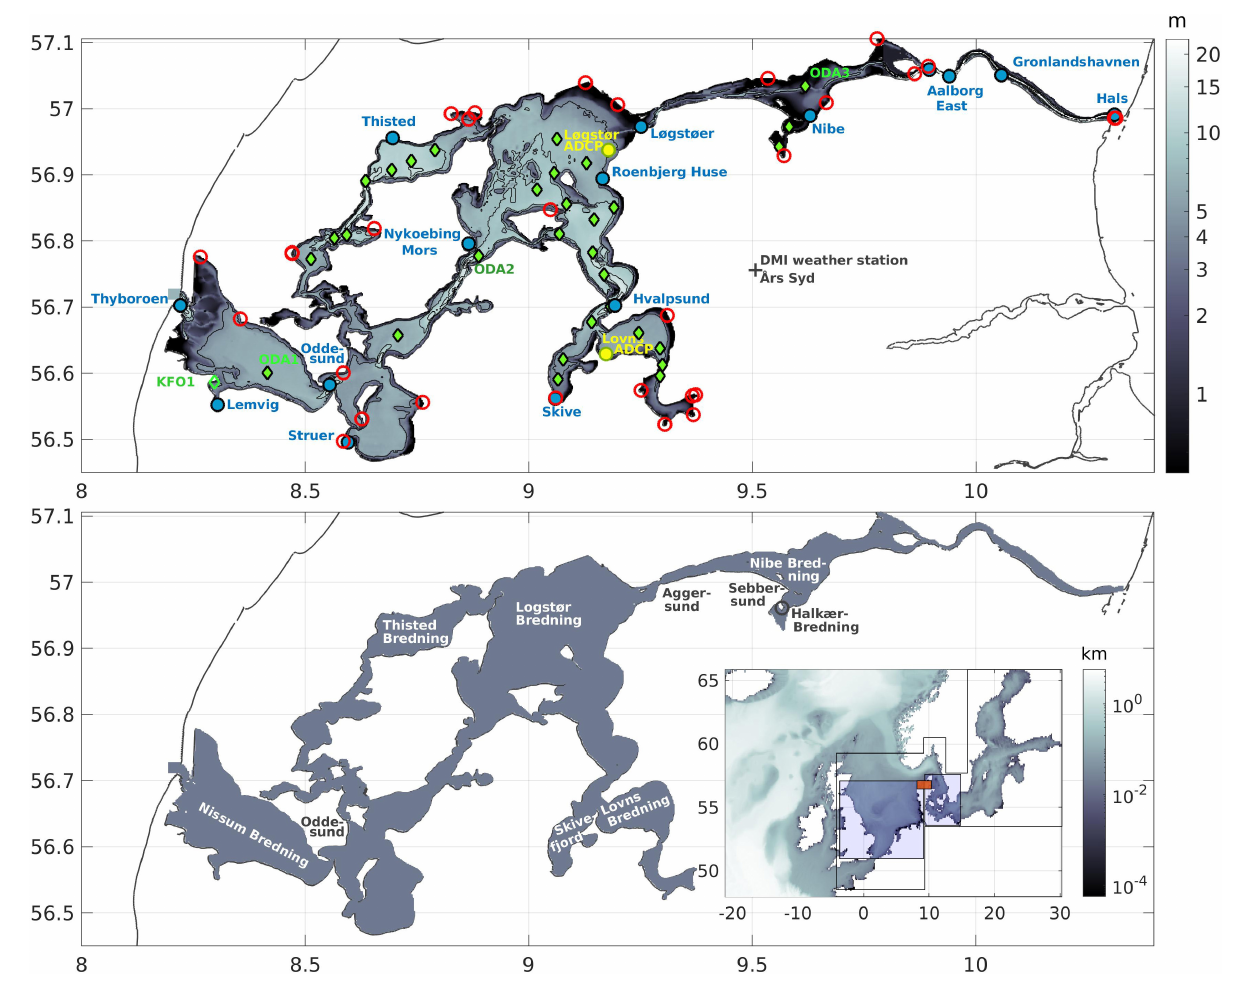
FIGURE 1 | HBM Limfjord model setup in 185.2 m resolution. Markers indicate the locations of the tide gauge stations (blue circles and names), ADCP current measurement stations Lovns and Løgstør (yellow dots), salinity and temperature validation stations (green diamonds) and river locations (red circles). Inset figure: Model configuration with a spatial resolution of 3 nmi in the North Sea and Baltic Sea, 1nm in the Waddensea, 0.5 nmi in the Danish straits and 185.2 m resolution in the Limfjord domain (red